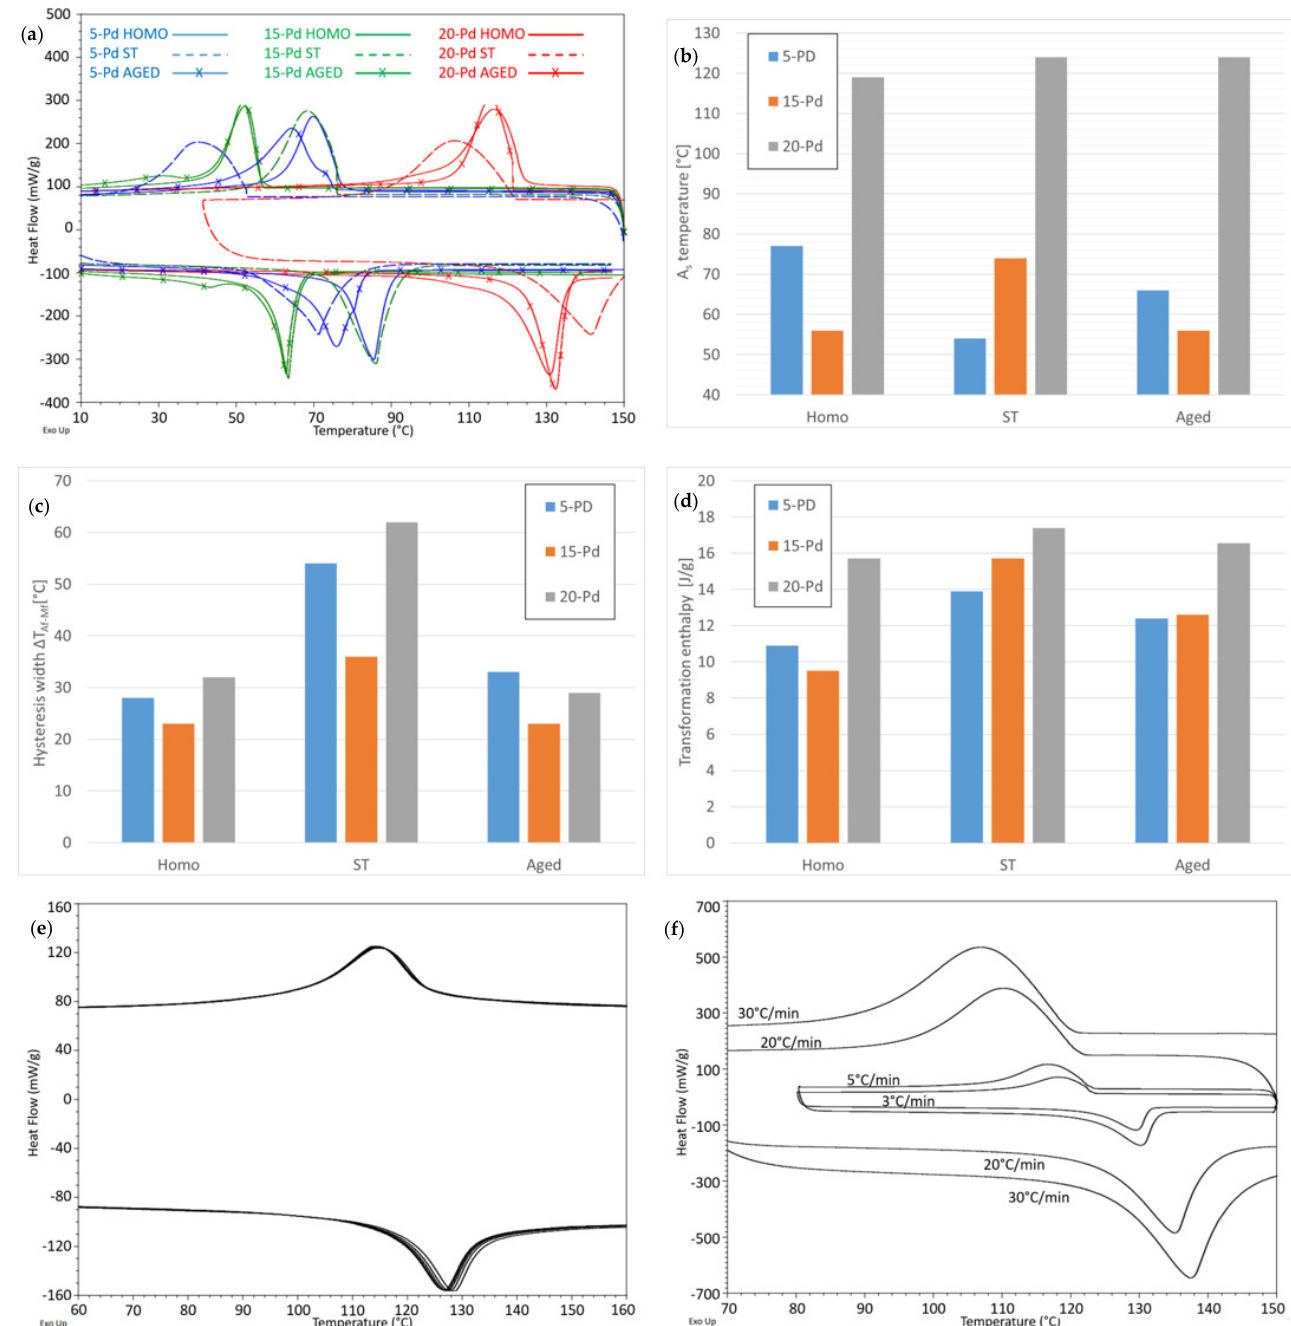
Figure 5. DSC results of alloy group B: ( a ) An overview of DSC curves after various heat treatments; ( b ) The austenitic transformation start temperature A s of heat treated alloys; ( c ) Hysteresis width of heat treated alloys, hysteresis is measured as difference between austenitic finish and martensitic finish temperature; ( d ) Enthalpy of the transformation measured as average of forward and backward transformation; ( e ) A representative curve of homogenized 20-Pd exposed to ten DSC cycles; ( f ) A representative curve of solution-treated 20-Pd cycled at different thermal rates ranging from 3–30 °C/min ( Δ T 30 °C/min − Δ T 3 °C/min ).